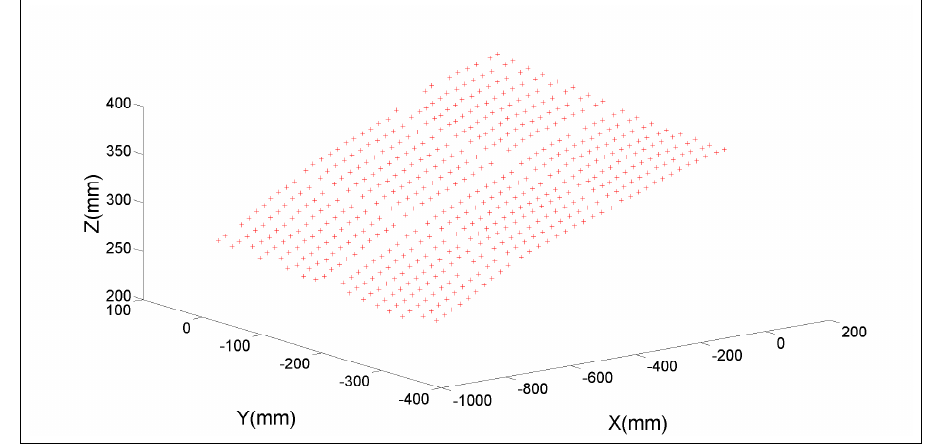
Figure 9. The result of six times experiments.